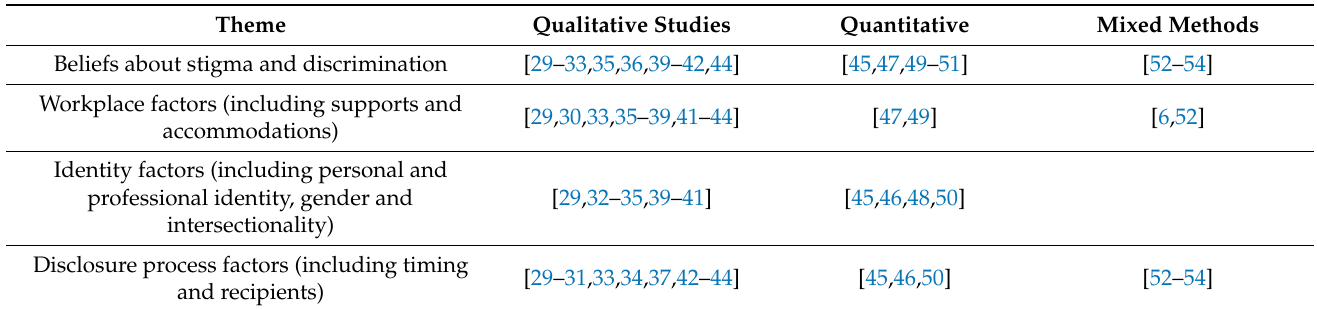
Table 2. Summary of main